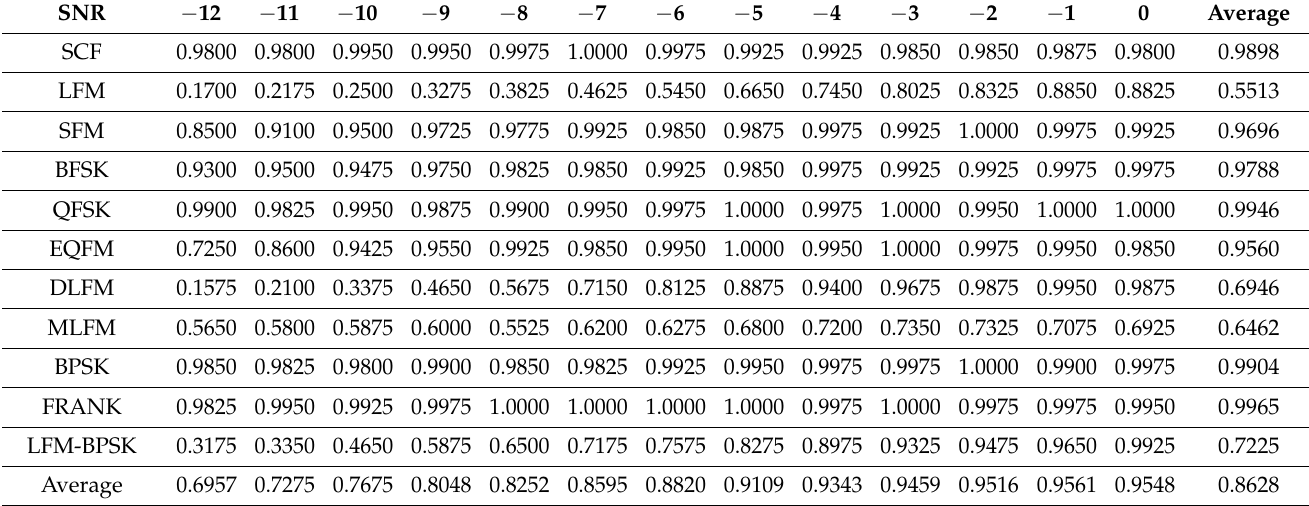
Table A24. Semi-supervised classification results with the datasets in Situation Dataset 4 ( d = 0.5 decreasing